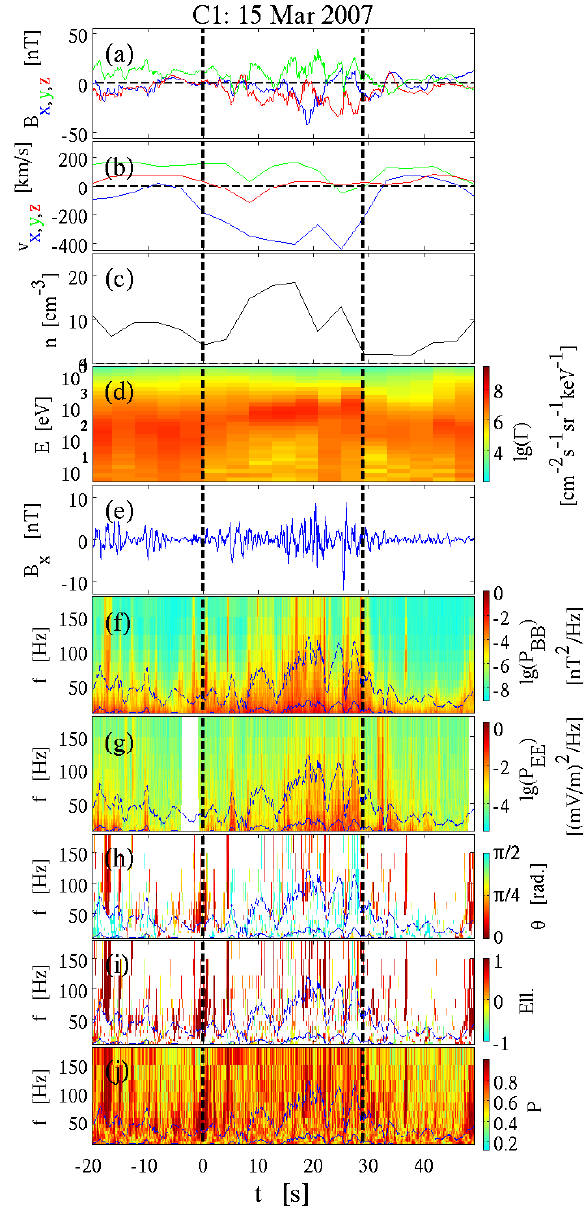
Figure 7. Data obtained by Cluster 1 on 15 March 2007. On the horizontal axis, time t = 0 corresponds to 10:21:05UT. (a) Mag- netic flux density in GSE coordinates; (b) ion bulk velocity in GSE coordinates; (c) ion density; (d) omnidirectional ion energy spectrum; (e) the x component of B measured by STAFF in the 0 . 6 Hz ≤ f ≤ 180 Hz frequency range; (f) power spectral density of | B | ; (g) power spectral density of | E | ; (h) propagation angle, i.e. the angle between k and B ; (i) ellipticity; (j) degree of polarisation. The vertical dashed lines mark the beginning and end of the plas- moid identified in Table 1. The blue curves on panels (f–j) show 0 . 1 f ce (upper curve) and f lh (lower